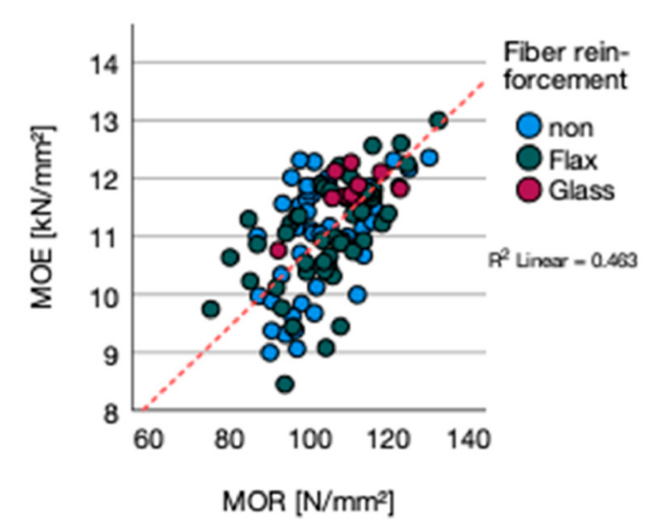
Figure 6. MOE vs. MOR.